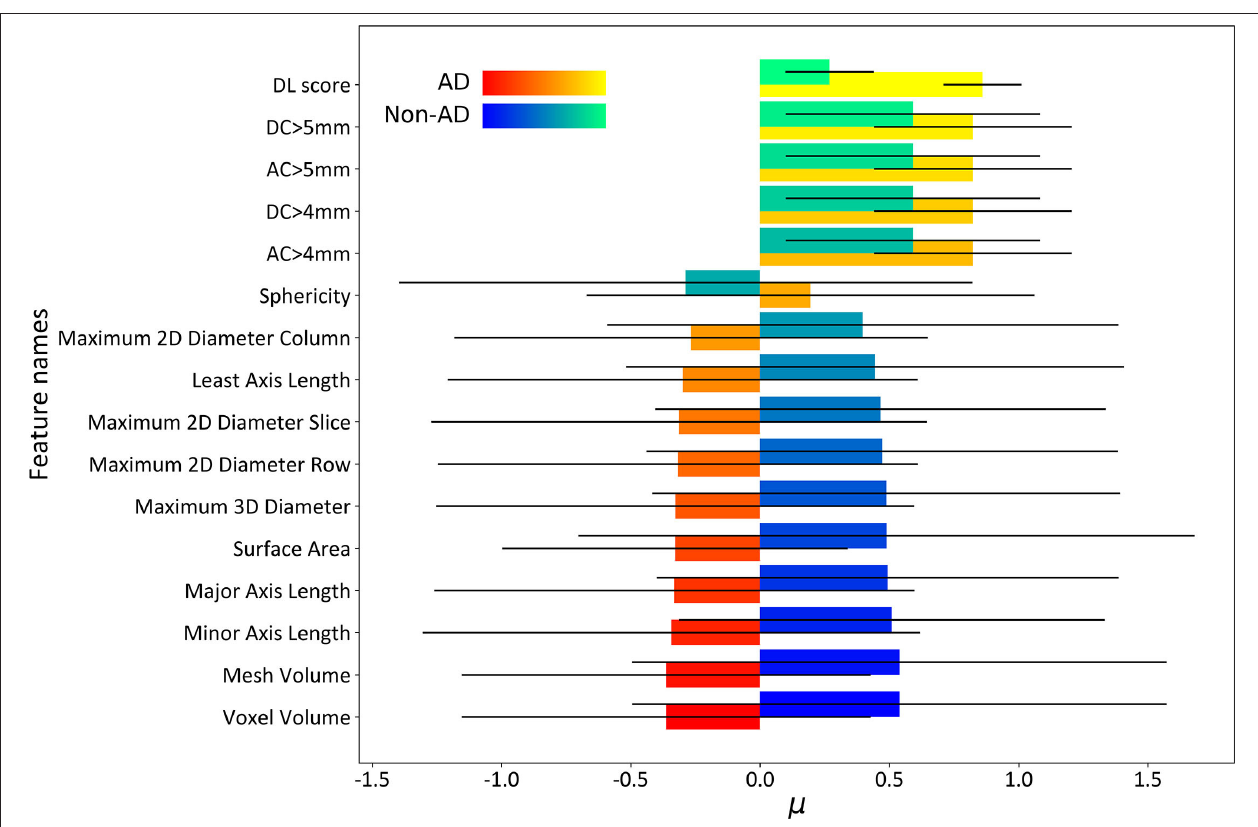
FIGURE 4 | The µ and σ parameters of the deep-integrated model. The σ parameter was used as an error bar. In general, patients with AD tend to have the higher DL scores and higher ascending aorta (AC) and descending aorta (DC). However, most of the general morphological features were lower in AD cases, except